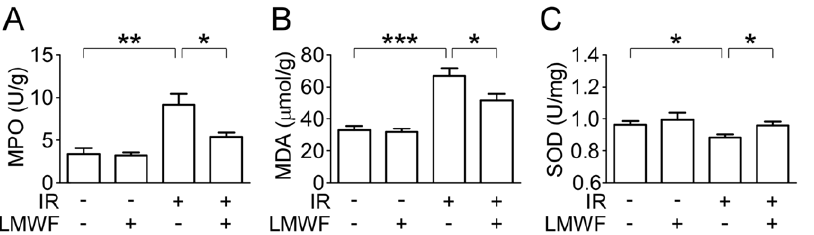
Figure 2. LMWF prevented renal oxidative stress and lipid peroxidation after IR. Kidneys after reperfusion for 24 h were collected for measurement. (A) MPO activity in renal tissue. (B) MDA concentration in renal tissue. (C) SOD activity in renal tissue. Data are presented as mean 6 SEM. n=5–8 for each group. * P , 0.05, ** P , 0.01, *** P , 0.001.